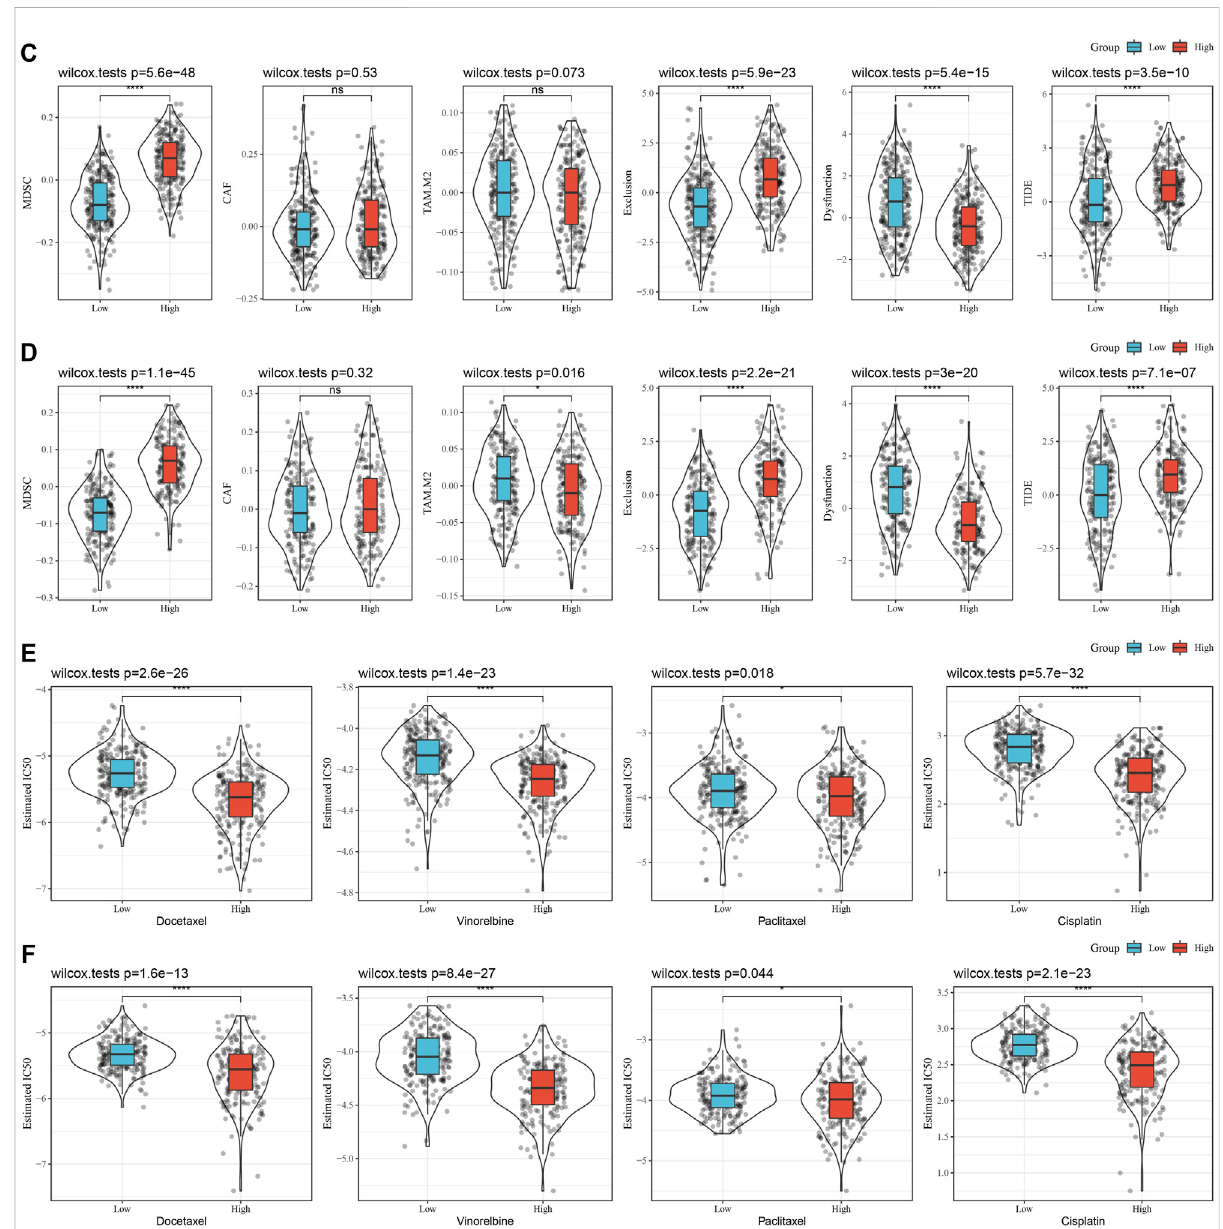
FIGURE 11 Differencesin immunotherapy/chemotherapy between RS groups. (A) Immune checkpoints differentially expressed among different groups in the TCGA cohort; (B) Immune checkpoints differentially expressed among different groups in the GSE72094 cohort; (C) differences in TIDE analysis resultsamongseparategroupsinTCGAqueue; (D) variations inTIDEanalysisresults amongdifferentgroupsinGSE72094 queue; (E) Boxdiagramof estimated IC50 of docetaxel, vinorelbine, paclitaxel, and cisplatin in TCGA; (F) Box diagram of estimated IC50 of docetaxel, vinorelbine, paclitaxel, and cisplatin in